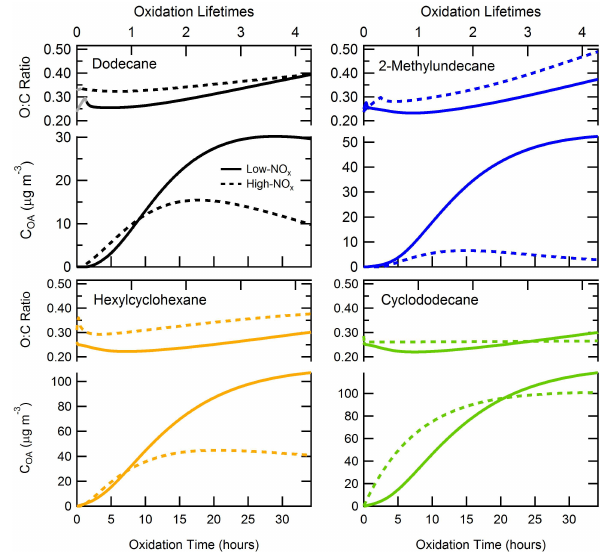
Fig. 5. Simulated time-evolution of C OA and O:C for each of the parent alkanes using the same reaction conditions but with compound-specific best-fit SOM parameters. Results are shown for low-NO x (solid) and high-NO x (dashed), assuming [OH]=2.5 × 10 6 moleculescm − 3 and [HC] 0